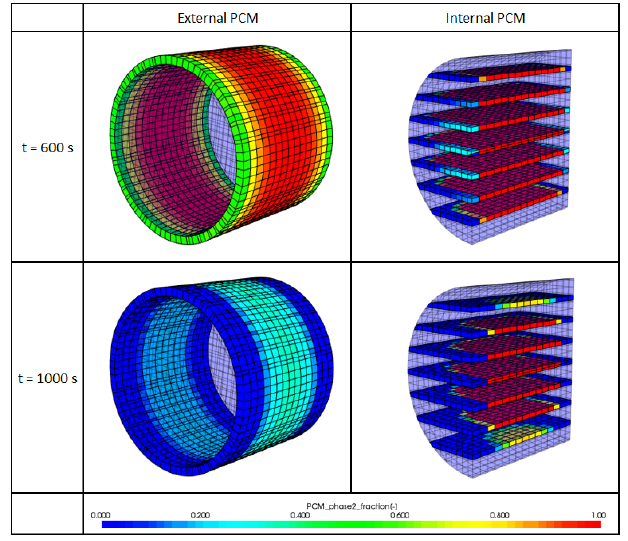
Figure 18. Status of phase changing process in external and internal PCM configuration during the cooling-down process under zero-flow conditions.